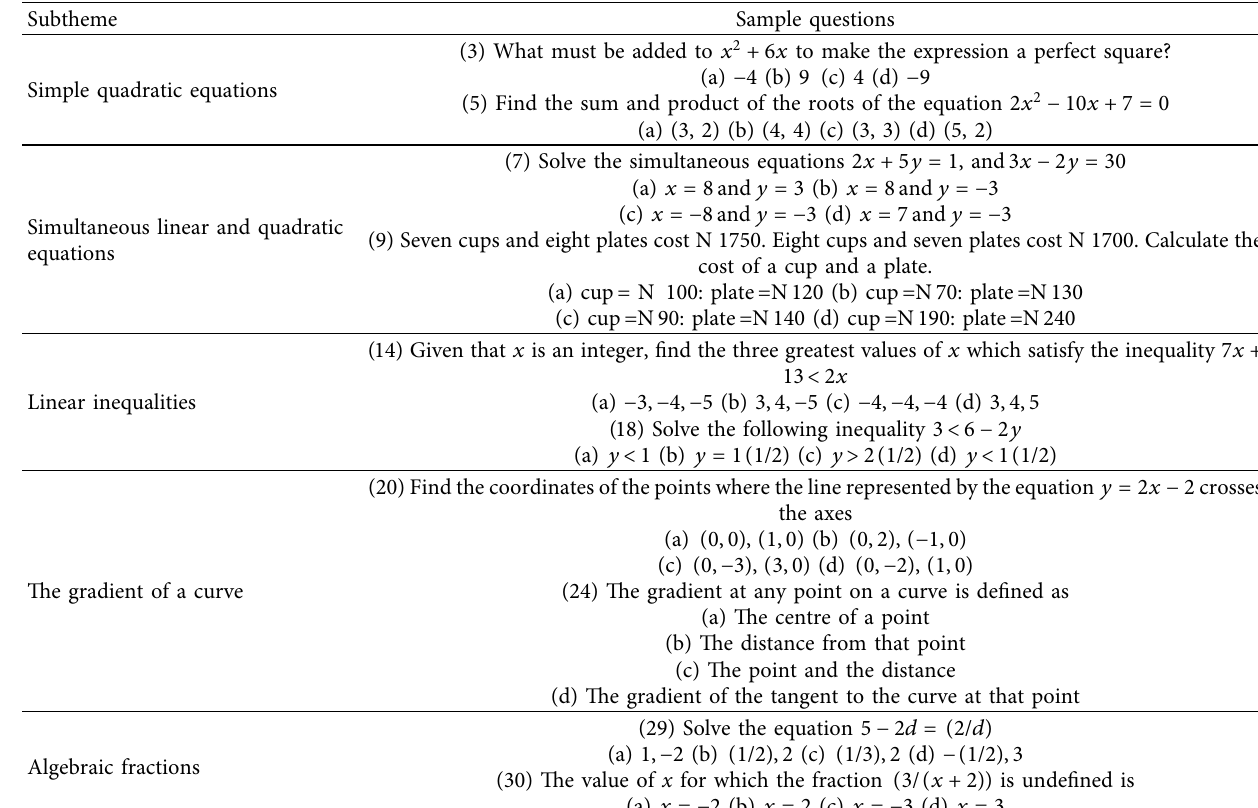
Table 1: Sample questions on the algebra performance